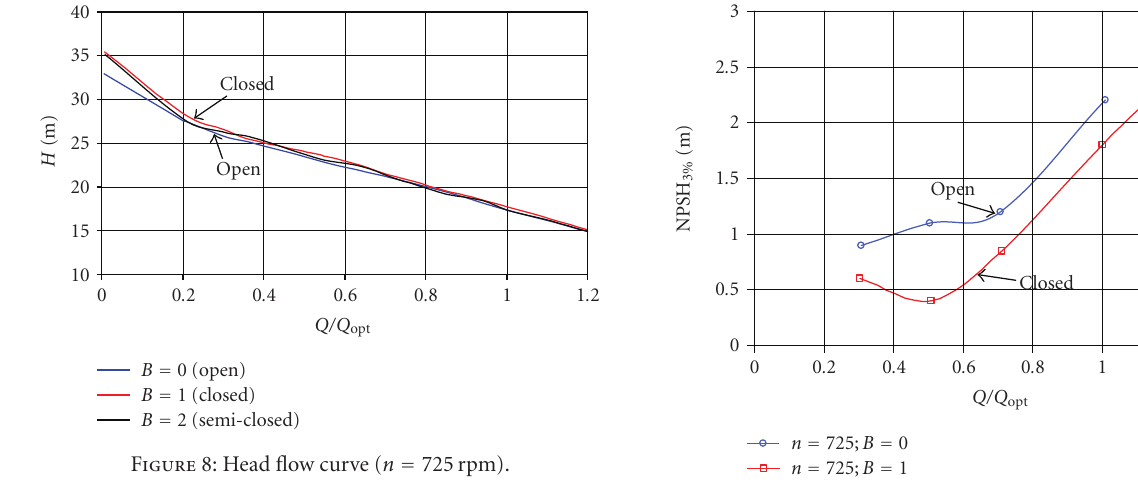
Figure 10: NPSH 3% ( n = 725 rpm).